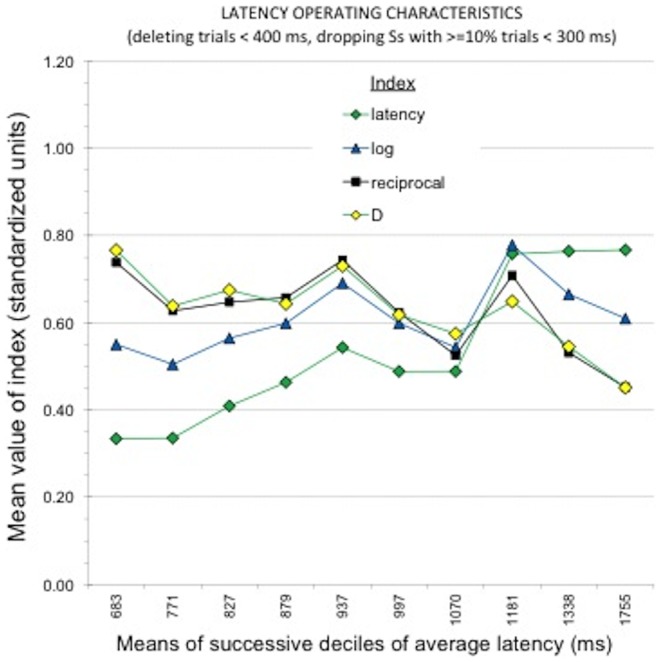
Latency operating characteristics, showing variation in mean standardized values of the five candidate BIAT scoring algorithms across deciles of the sample's distribution of average speed of responding for the political BIAT.Pretreatment of the data involved removing 4 warm-up trials per block, latencies slower than 10s, and latencies faster than 400 ms. There were 202 or 203 respondents in each decile. The most noticeable effects visible in the graph are improvement in performance of the reciprocal measure relative to its poor showing in Fig. 2, and the contrast between the relative stability across speed variations for four of the measures and the increasing magnitude of the (untransformed) latency-difference measure as responding went from fast (left of graph) to slow.